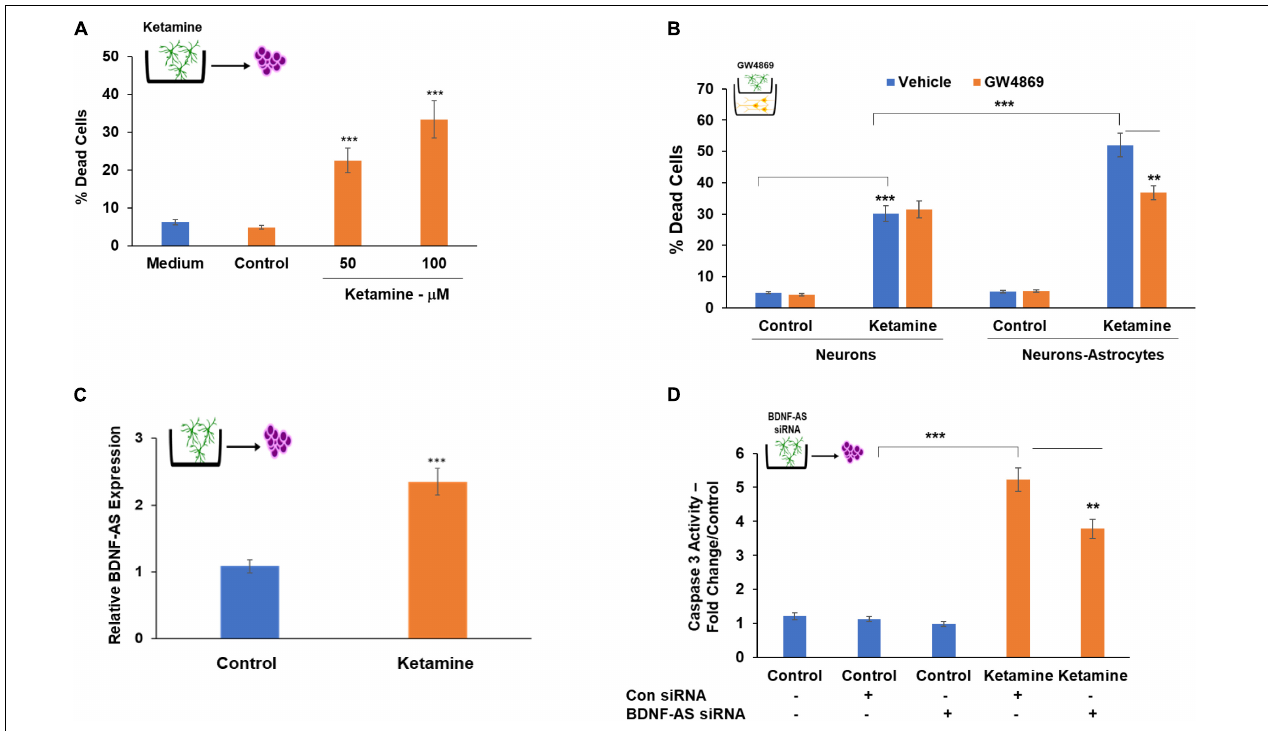
FIGURE 6 | Astrocyte-secreted EVs mediate the increased neurotoxic effects of ketamine in neuron-astrocyte co-cultures. Cultured neurons were treated with EVs isolated from control or ketamine-treated astrocytes. Percent of dead cells was determined after 48 h (A). To further analyze the role of EVs secreted from astrocytes, these cells were pre-treated with GW4869 (20 µ M) prior to ketamine treatment. The treated astrocytes were then co-cultured with neurons and treated with ketamine (50 µ M). Neuronal cells death was analyzed after 48 h (B) . A similar treatment of GW4869 was performed in neuronal cells cultured alone (B) . The expression of BDNF-AS in EVs isolated from control and ketamine-treated astrocytes was analyzed by RT-PCR (C). EVs isolated from astrocytes that were silenced for BDNF-AS and then treated with ketamine were added to neuronal cultures. Cell death was determined after 48 h (D) . The results are the means ± SD of six independent experiments analyzed in quadruplets. ** P < 0.01 and *** P <